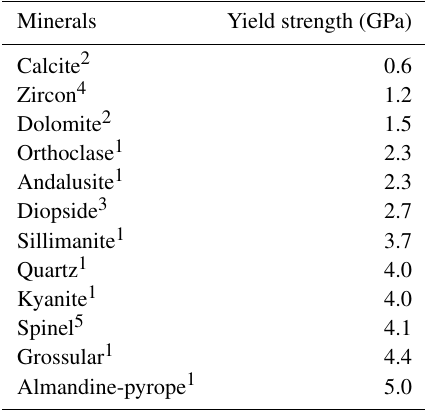
Table 1. Averaged plastic strength from microhardness tests for some minerals at room conditions. Strength is converted from mi- crohardness based on C h = H/C g , where the geometry constant C g is taken as 3. Raw data are dependent on crystallographic orienta- tion, composition, and applied load that are examined in some of the involved